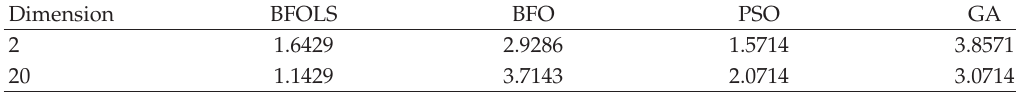
Table 4: Average rankings of the four algorithms on dimensions of 2 and 20.